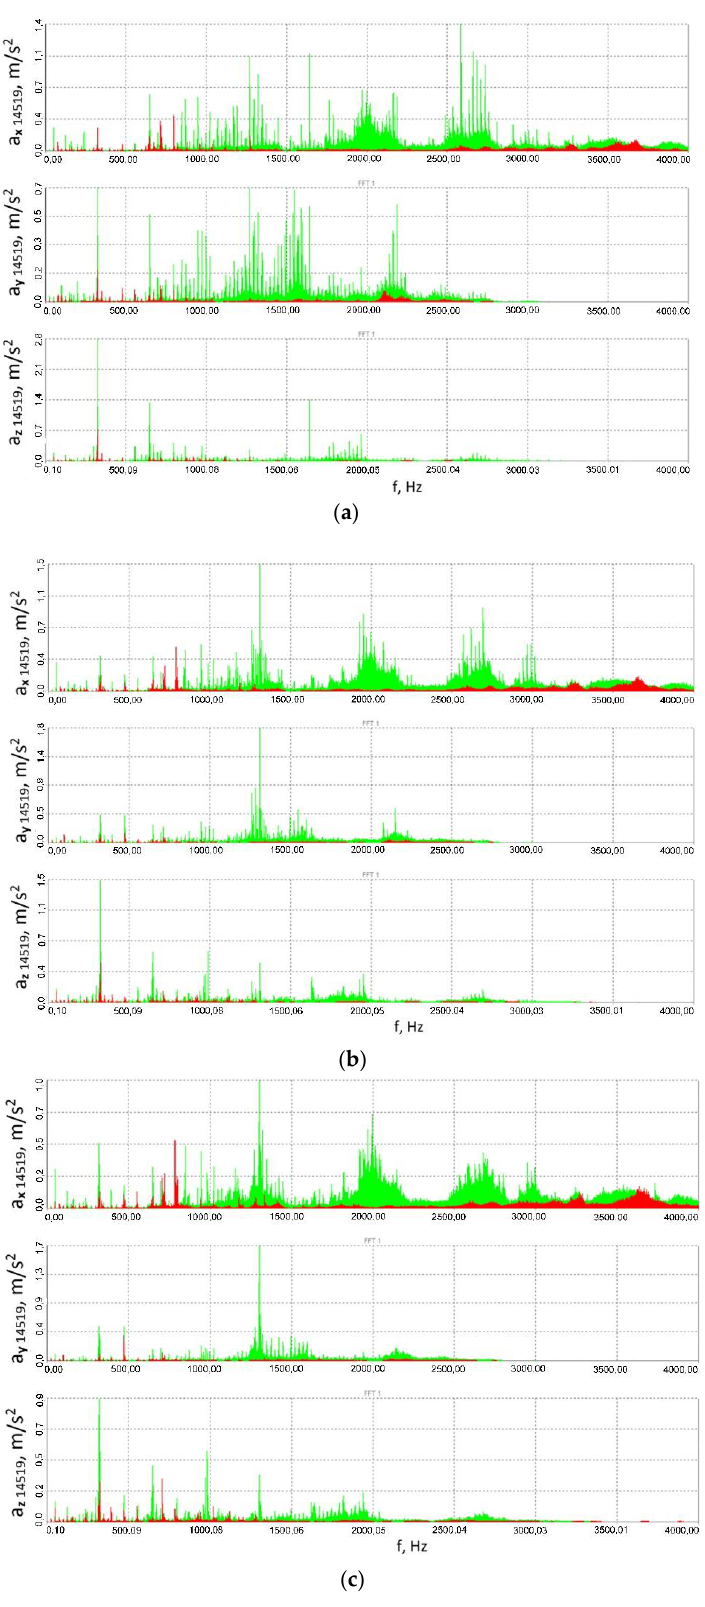
Figure 16. Spectra (FFT) of the vibration acceleration signals measured at the output shaft housing in the multi-stage reduction gear (point 14519): ( a ) 41.8 ± 27.9 Nm, ( b ) 79.2 ± 55 Nm, ( c ) 114.8 ± 75.9 Nm; red colour corresponds to the flexible clutch operation mode, green — locked clutch operation mode.